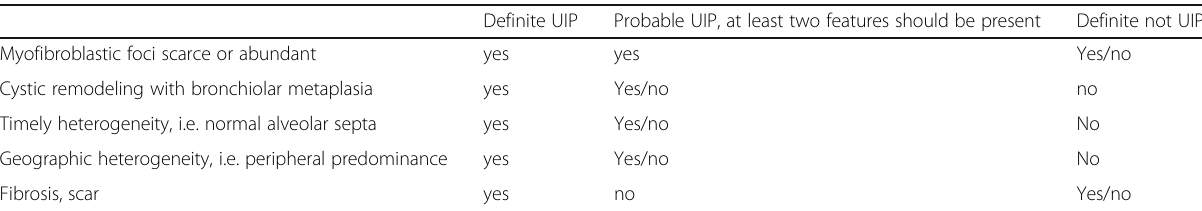
Table 1 Criteria of UIP pattern Definite UIP Probable UIP, at least two features should be present Definite not UIP Myofibroblastic foci scarce or abundant yes yes Yes/no Cystic remodeling with bronchiolar metaplasia yes Yes/no no Timely heterogeneity, i.e. normal alveolar septa yes Yes/no No Geographic heterogeneity, i.e. peripheral predominance yes Yes/no No Fibrosis, scar yes no